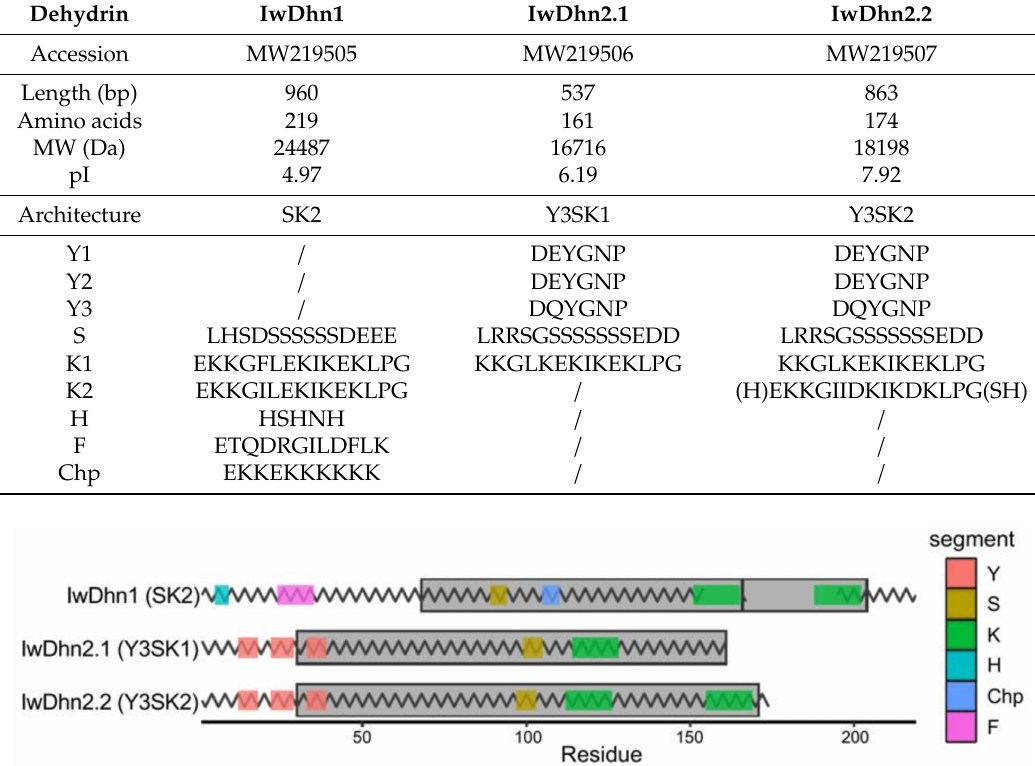
Figure 8. Schematic representation of three I. walleriana dehydrins. Grey boxes represent Dehydrin domains (pfam PF00257) according to hmmscan. The zig-zag lines represent disordered regions of proteins according to Espritz model with the default settings. Structural segments of dehydrins are shown as colored boxes. The drawing is to